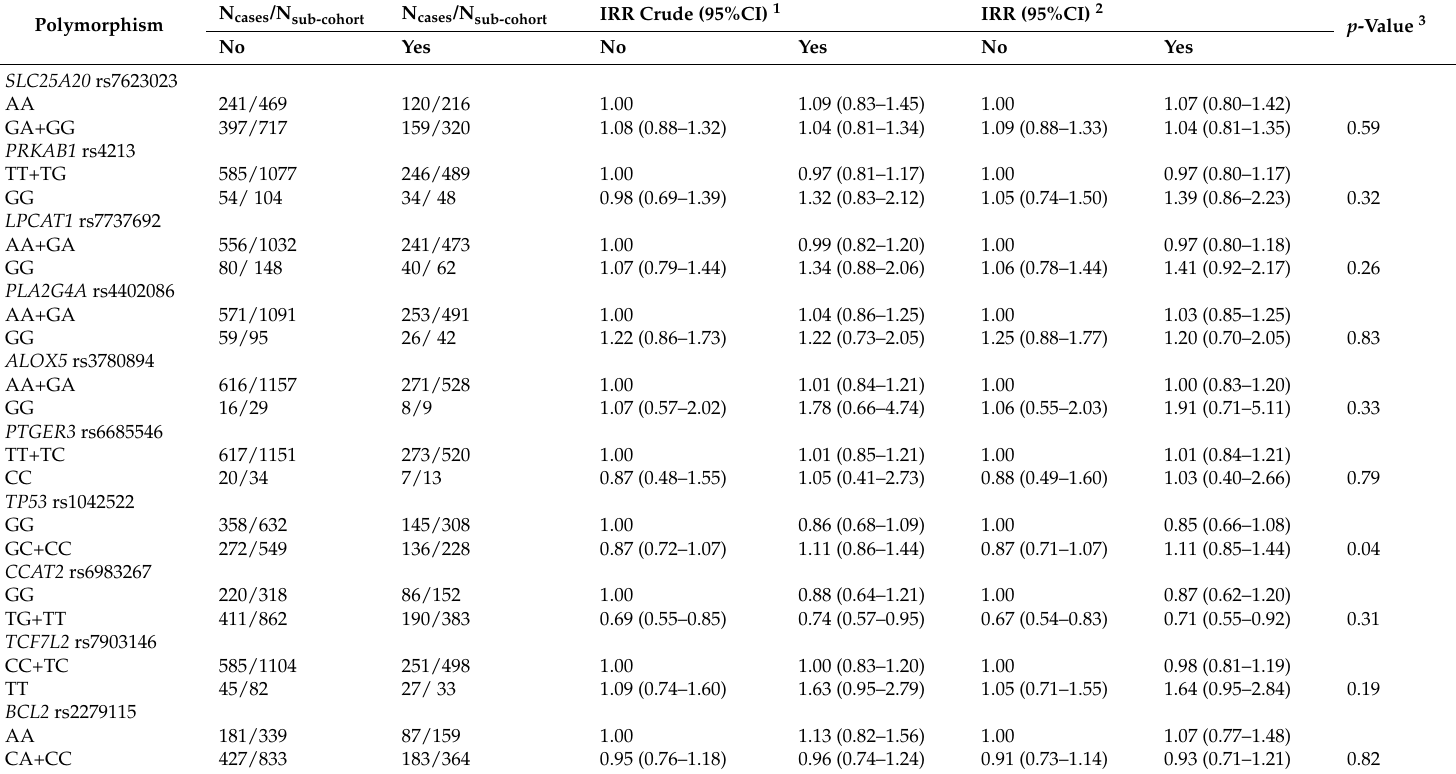
Table 3. Interactions between polymorphisms and use of non-steroid anti-inflammatory drugs (NSAID).